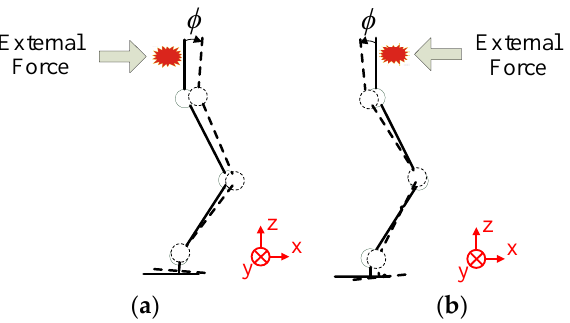
Figure 6. Two types of the external force for the humanoid robot. ( a ) From the back. ( b ) From the front.